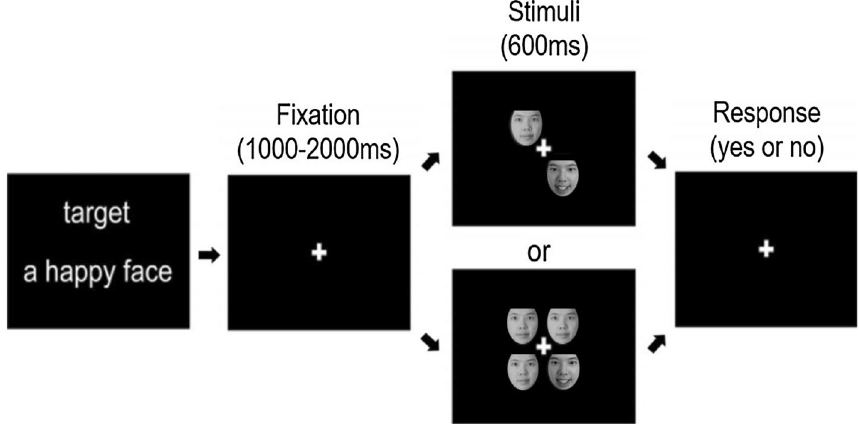
Figure 1. Schematic demonstration of the experimental procedure for happy face search. The face in the picture is from the first author of this study, Qijie